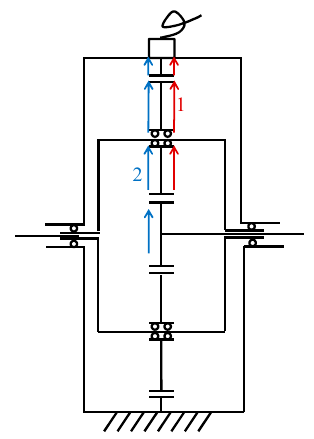
Figure 2. Vibration signal transmission in planetary gearbox. 1. From planet gear to gear ring, to housing, then to sensors; 2. From sun gear to planet gear, to gear ring, to housing, then to sensors.